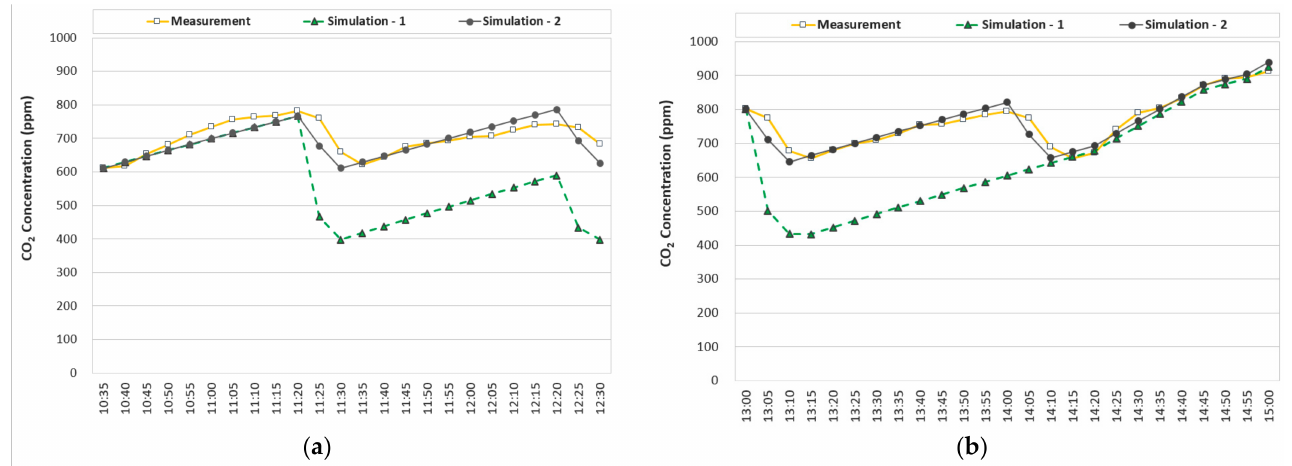
Figure 16. CO 2 data for a single-person office space on February 15, 2022. ( a ) Morning period. ( b ) Afternoon period.